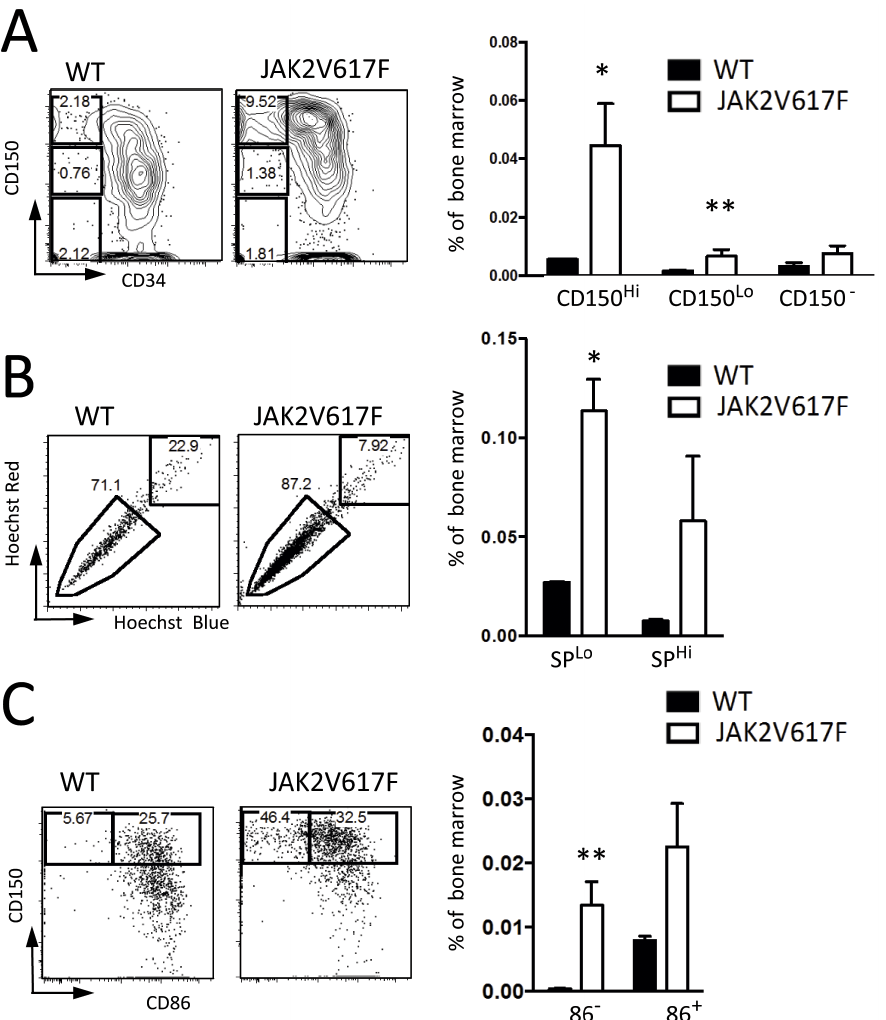
Figure 2. Particular HSC subsets expand in JAK2V617F Tg mice. ( A ) LSK were resolved with CD150 and CD34. CD34 2 CD150 Hi , Lo , and negative HSC were gated as described by Morita [10]. The percentages of CD34 2 HSC subsets in BM were calculated. Closed and open circles indicate individual WT and JAK2V617F mice, respectively. The data are representative of those obtained in two independent experiments (N=6). ( B ) Lower side population cells in BM (spindle-shaped gating) are thought to include myeloid biased HSC. The ‘‘side population tip’’ was increased in JAK2V617F mice. Representative plots are shown in the left panels, while cell percentages of lower and upper cells are given in right panels. ( C ) Both CD86 2 and CD86 + CD150 + CD48 2 LSK cells in BM were increased in JAK2V617F mice. CD48 2 LSK were resolved with CD86 and CD150. Cell percentages of CD86 2 and CD86 + in CD150 Hi were calculated. The data are representative of those obtained in three independent experiments (N=8) p , 0.01(**), p ,